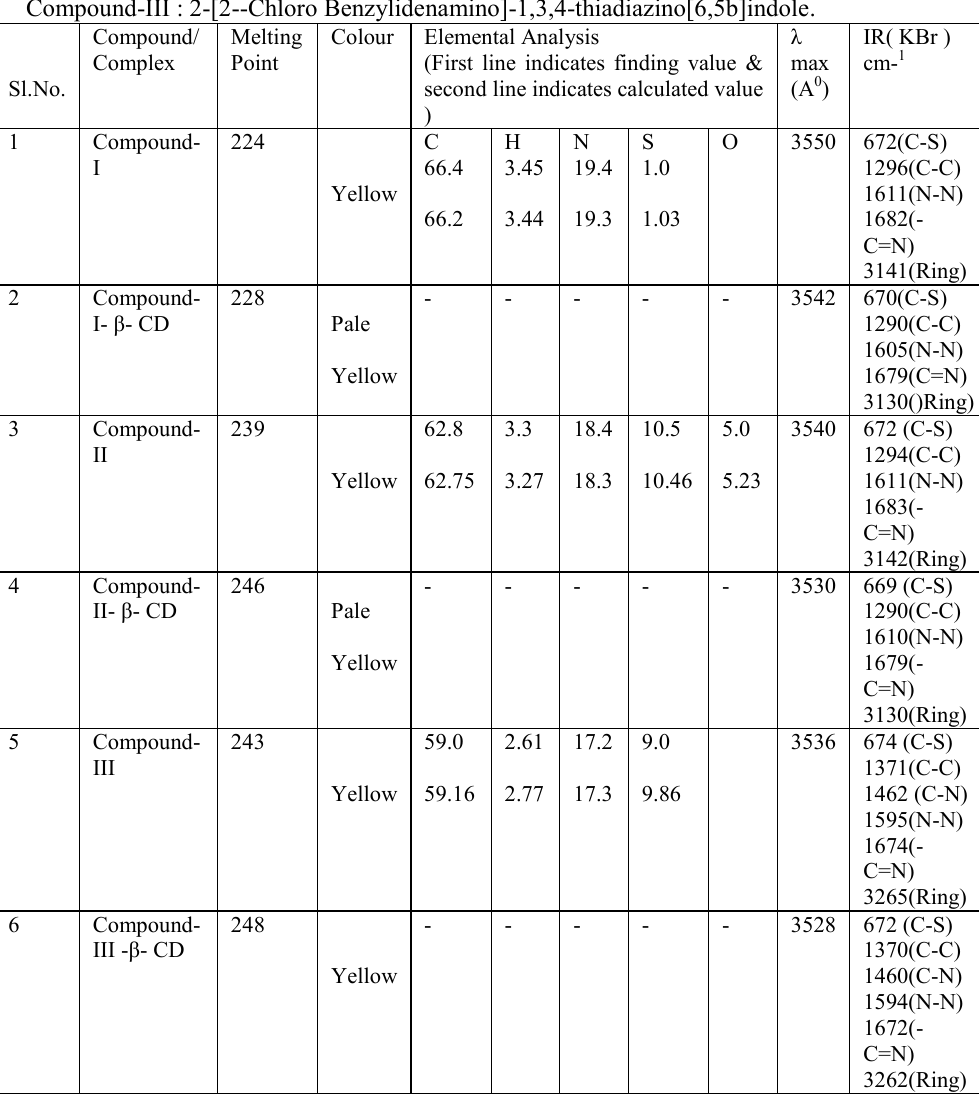
Table 1: Analytical data of Compounds with and without inclusion complex. Compound-I : Benzylidenamino-1,3,4-thiadiazino[6,5b]indole. Compound-II : 2-[2- Hydroxy Benzylidenamino]-1,3,4-thiadiazino[6,5b]indole. Compound-III : 2-[2--Chloro Benzylidenamino]-1,3,4-thiadiazino[6,5b]indole.